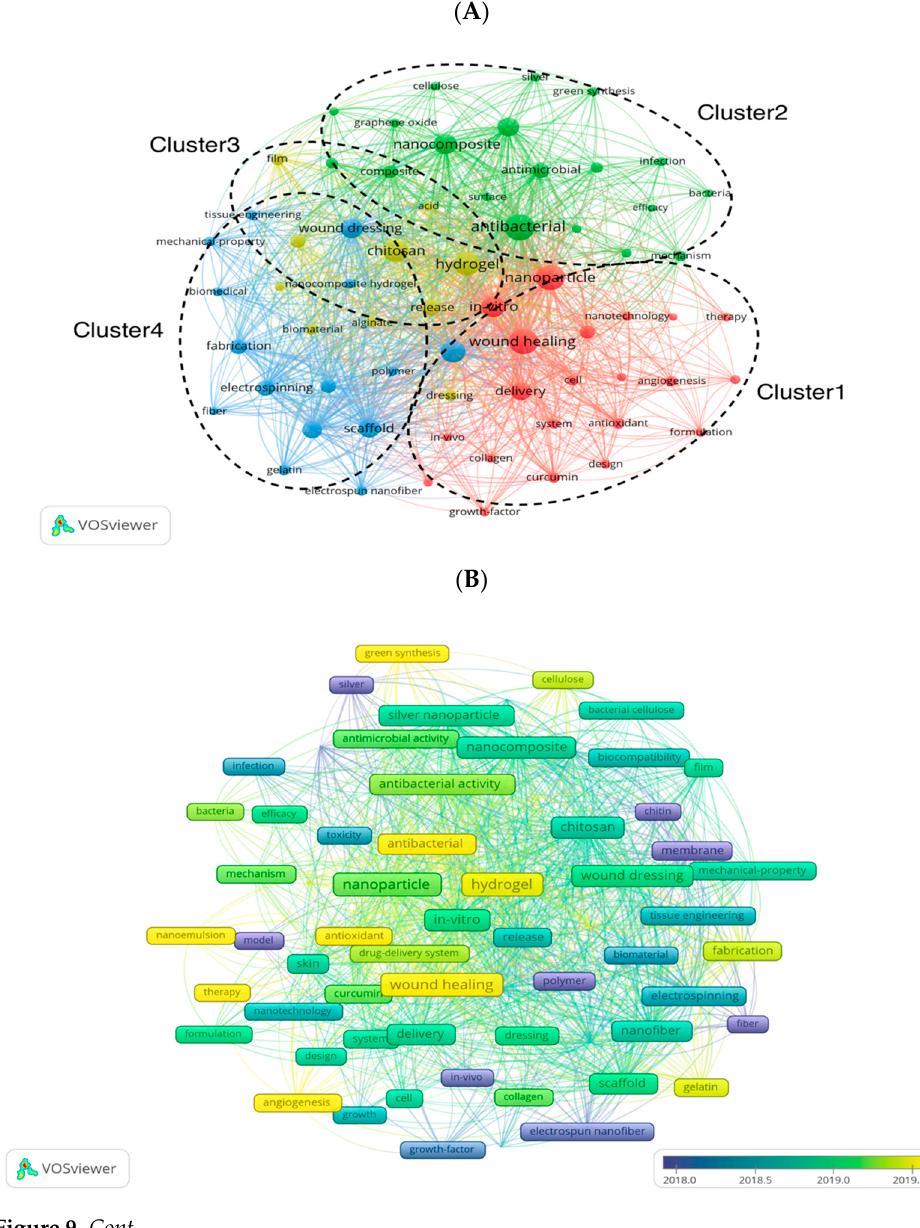
( C ) Figure 9. Cont